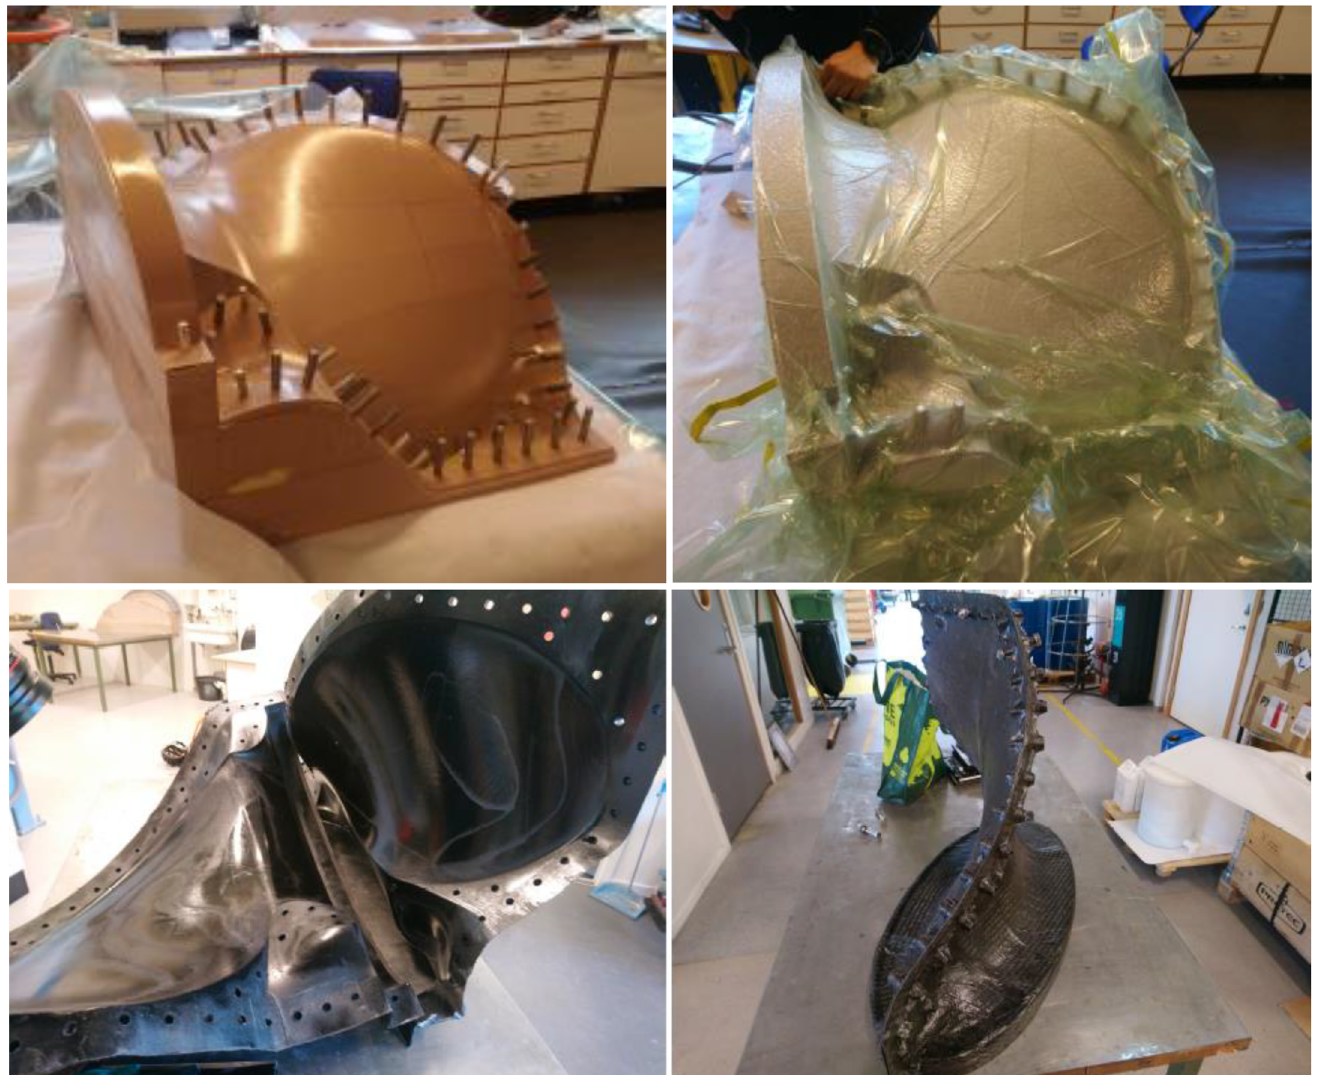
Figure 6. Top left: Mould pattern with alignment pins. Top right: Vacuum bagged during debulking of plies and curing of mould half. The finished mould is shown in the bottom two pictures. Photos from [10,11].